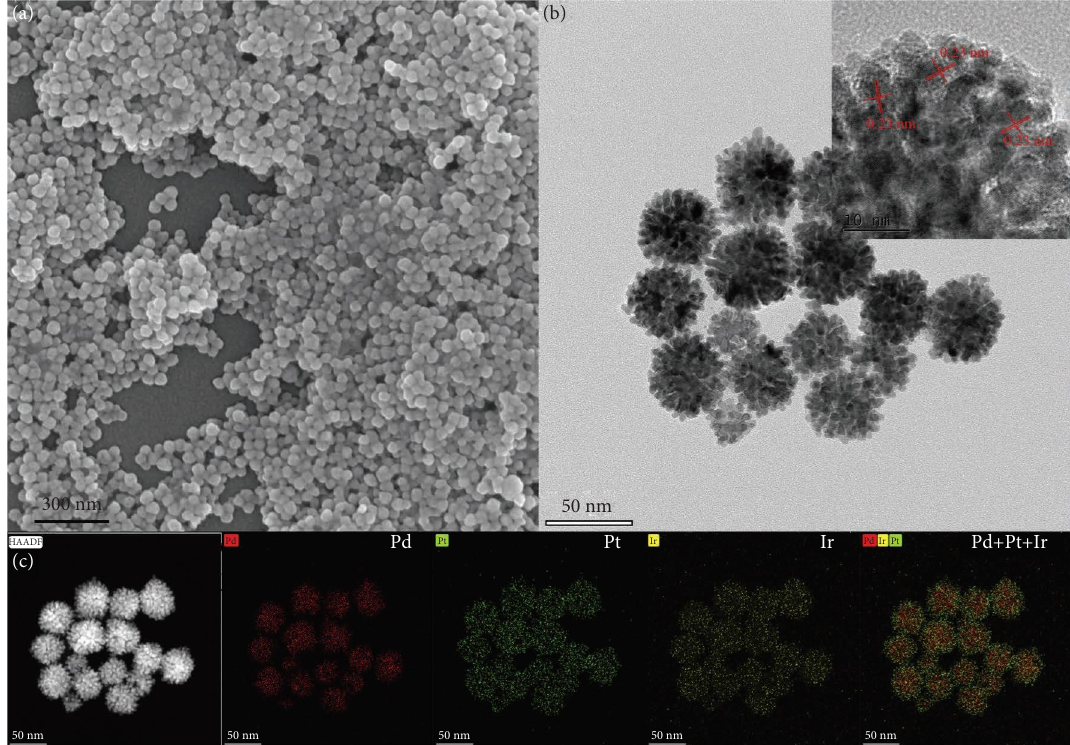
Figure 1: Te SEM pattern of DA-PPI nanozyme (a). Te TEM and HRTEM (inset pattern) pattern of DA-PPI nanozyme (b). Te element distribution of DA-PPI nanozyme